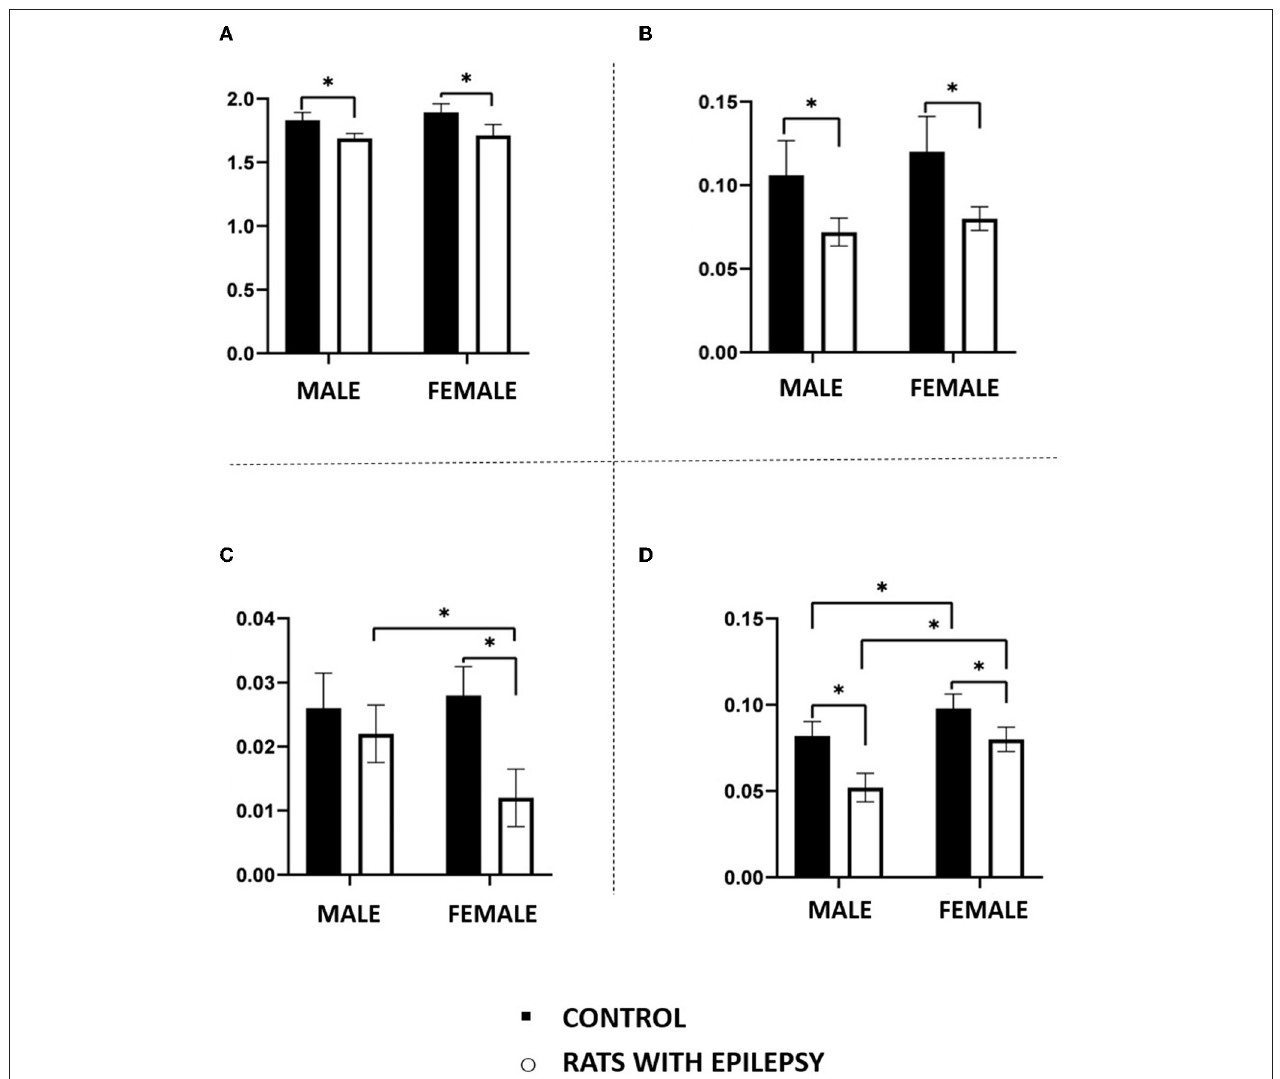
FIGURE 3 | Mass (in grams) in the total brain (A) , hippocampal formation (B) , amygdala (C) , and olfactory bulb (D) obtained from male and female rats submitted to the pilocarpine model of epilepsy in relation to that of the respective controls. Data are expressed as mean ± SD. Data from rats with epilepsy were compared with those of their respective controls using two-way ANOVA followed by Tukey’s post-hoc test. * p <